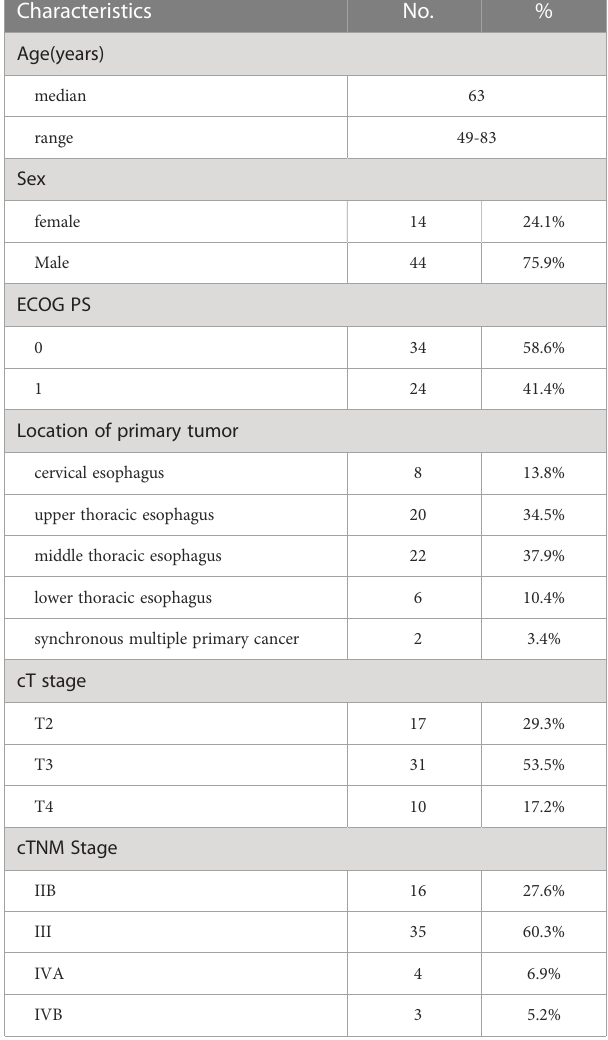
TABLE 1 Patient characteristics for the whole cohort